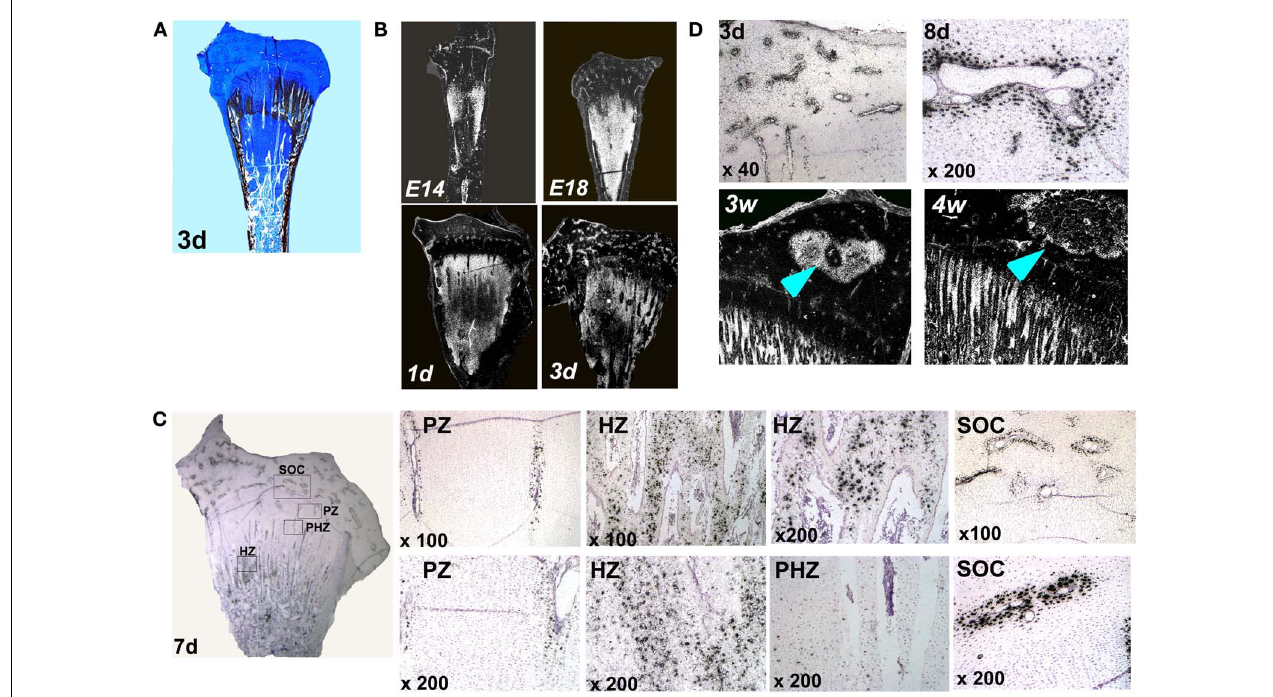
zone – expression in hypertrophic chondrocytes; PHZ, pre-hypertrophic zone – no expression in the pre-hypertrophic zone; SOC,